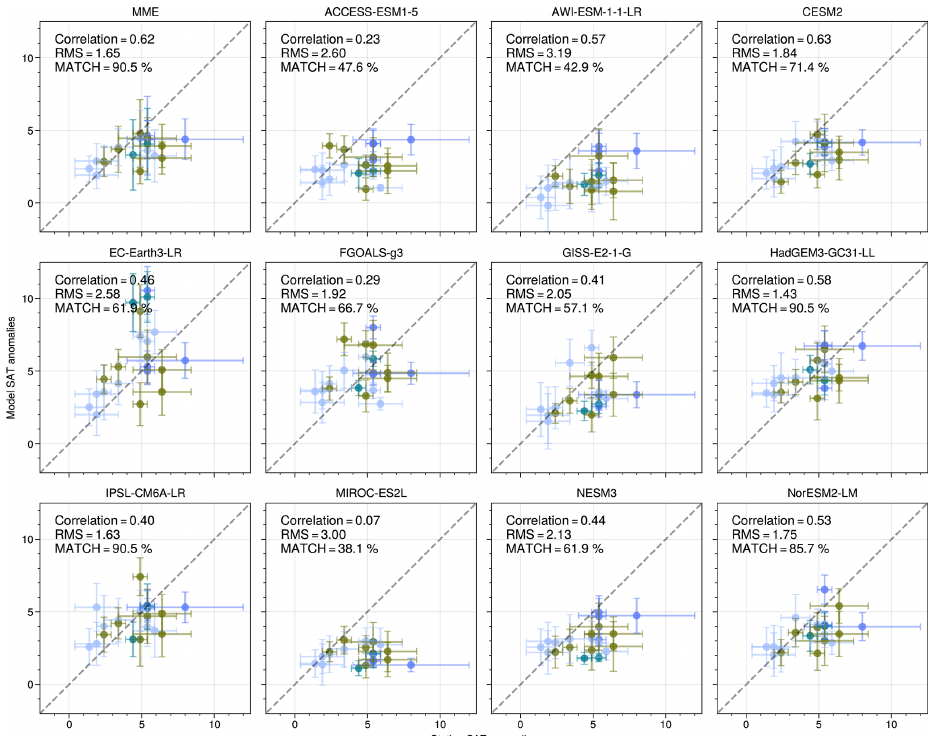
Figure A3. Modelled (cid:49) SSAT versus proxy (cid:49) SSAT. The scatter points show model data versus reconstructions for each proxy location. Error bars represent 1 standard deviation on either side of the proxy estimate. The correlation coefficients between X and Y , RMSE, and percentage matches with proxy data for each model are indicated in each panel.